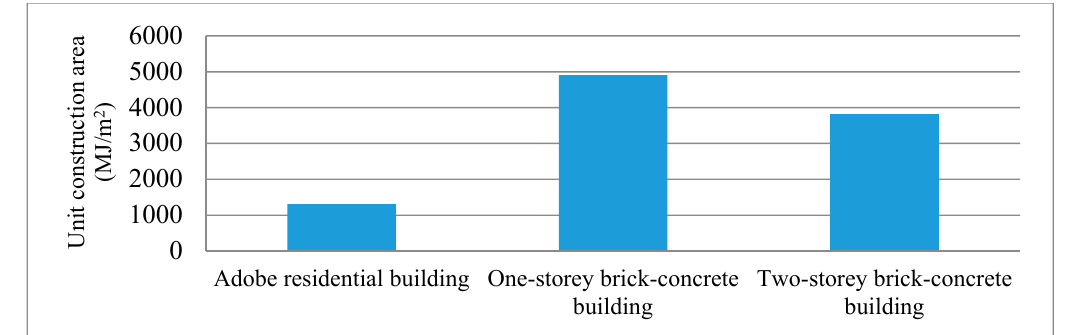
Figure 7. Energy demand of building materials manufacture in unit construction area (MJ).